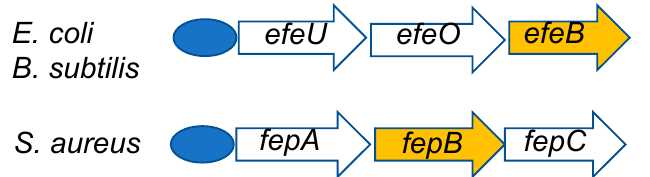
Figure 5. Schematic depiction of efeUOB and fepABC operons. Both operons are regulated by the Fur repressor (blue oval). efeB and fepB are orthologs of each other and encode DyP-type peroxi- dases.